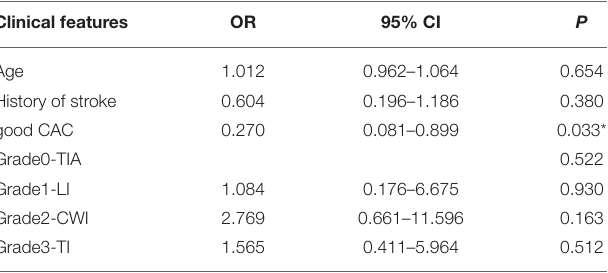
TABLE 4 | Multivariable models (Enter) of the association between APMV and clinical and radiological markers in patients with ICAO. Clinical